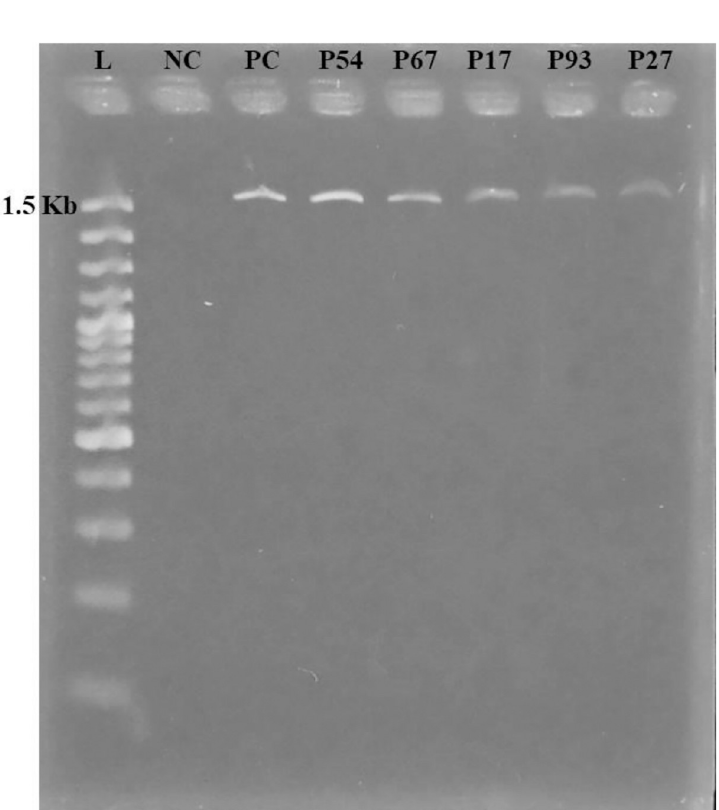
Fig 6. Detection of plasmid by agarose gel electrophoresis. Agarose gel electrophoresis (2%) was used for separation of the whole plasmid. Here, M indicates Marker (100 bp); N as the negative control, Nuclease free water; PC indicates positive control, Klebsiella pneumoniae containing the plasmid. All positive isolates had a band size of 1500 bp.